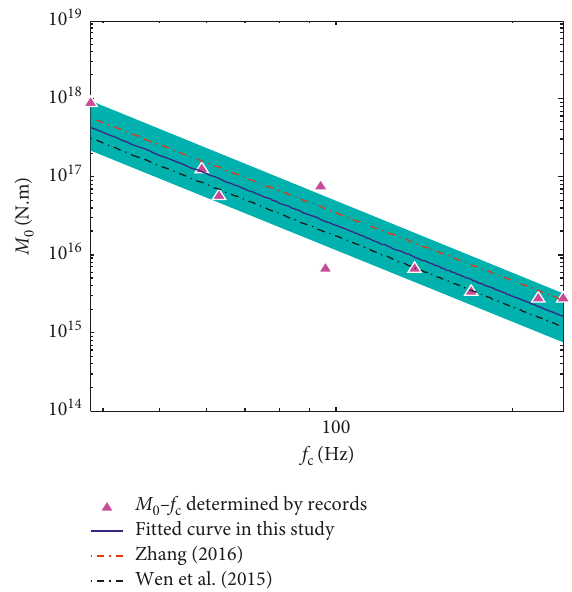
Figure 10: Seismic moment M 0 versus the corner frequency f c